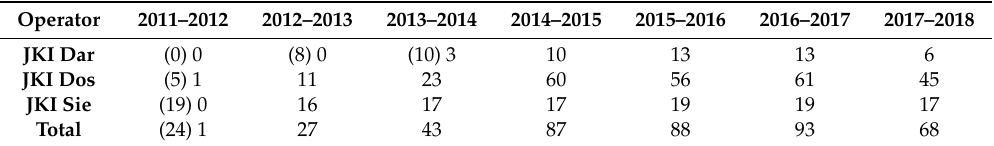
Table 4. The number of traps monitored by each institute for each D. suzukii -year. Given in brackets are the number of traps that were not included in this study, as these traps were in operation before the first catch of D. suzukii